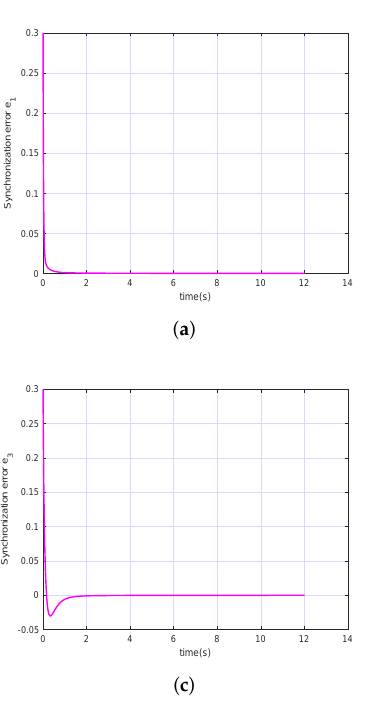
Figure 5. State trajectories of the drive and slave systems in Example 2: ( a ) x 1 v.s. y 1 , ( b ) x 2 v.s. y 2 , ( c ) x 3 v.s. y 3 .